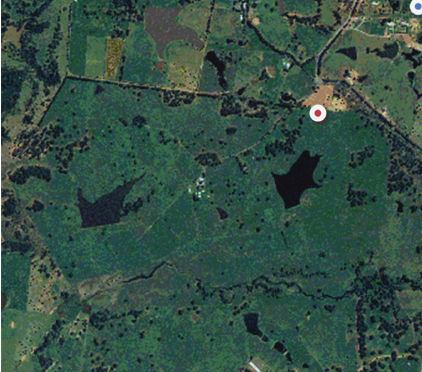
Figure 1: Sampling locations: the blue dot indicates PBI, and the red dot indicates JBP.